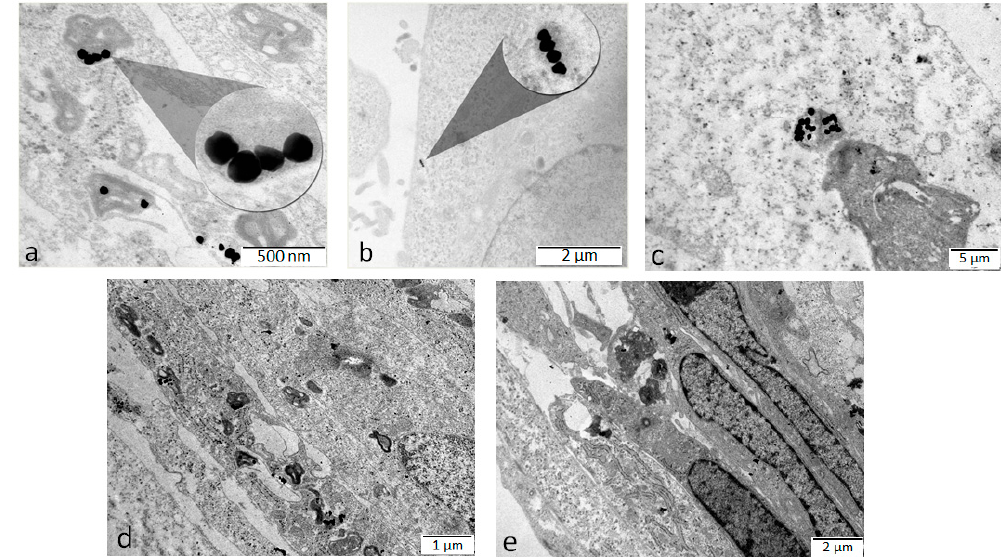
Figure 6. TEM micrographs obtained from ( a,d , e ) HFL-1 and ( b , c ) D407 cells treated by 75 × 10 –13 M AuNPs for 24 h. The images show the intracellular distribution of the AuNPs in the cells. All the observed intracellular AuNPs were either clustered inside lysosomes or cytosol compartments. Scale